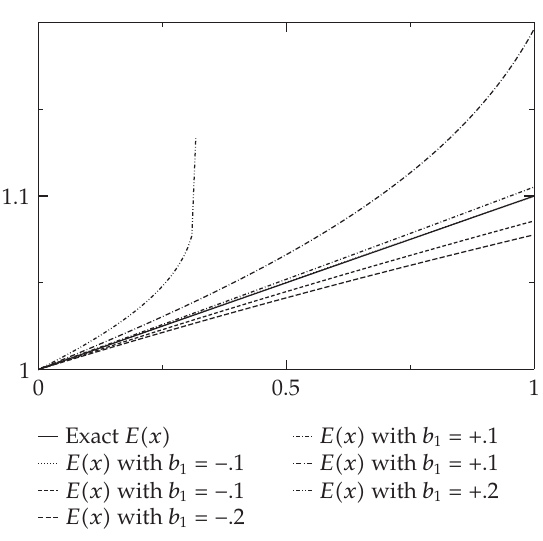
Figure 8.1 . The reconstructed elastic modulus E ( x ) = 1 + . 1 x for var- ious b 1 values using n = 128 grid points.